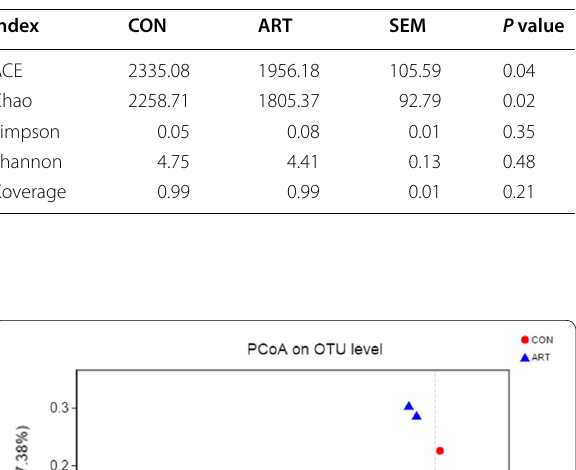
Table 3 Effect of ART on alpha diversity indexes of milk